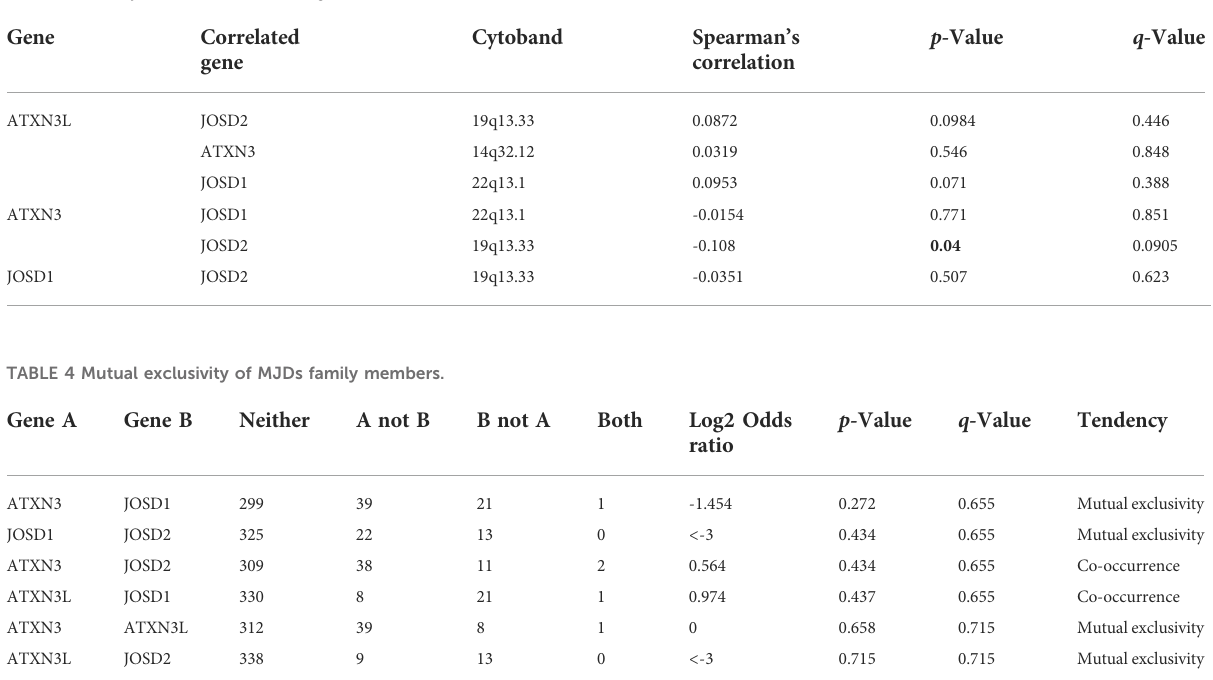
TABLE 3 Co-expression of MJDs family members